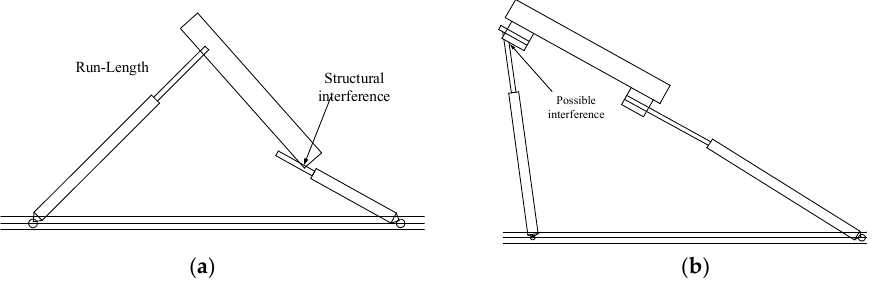
Figure 6. Schematic diagram of the limit pose of interference. ( a ) The situation when left electric cylinder reaches the limit length. ( b ) The situation when right electric cylinder reaches the limit length.